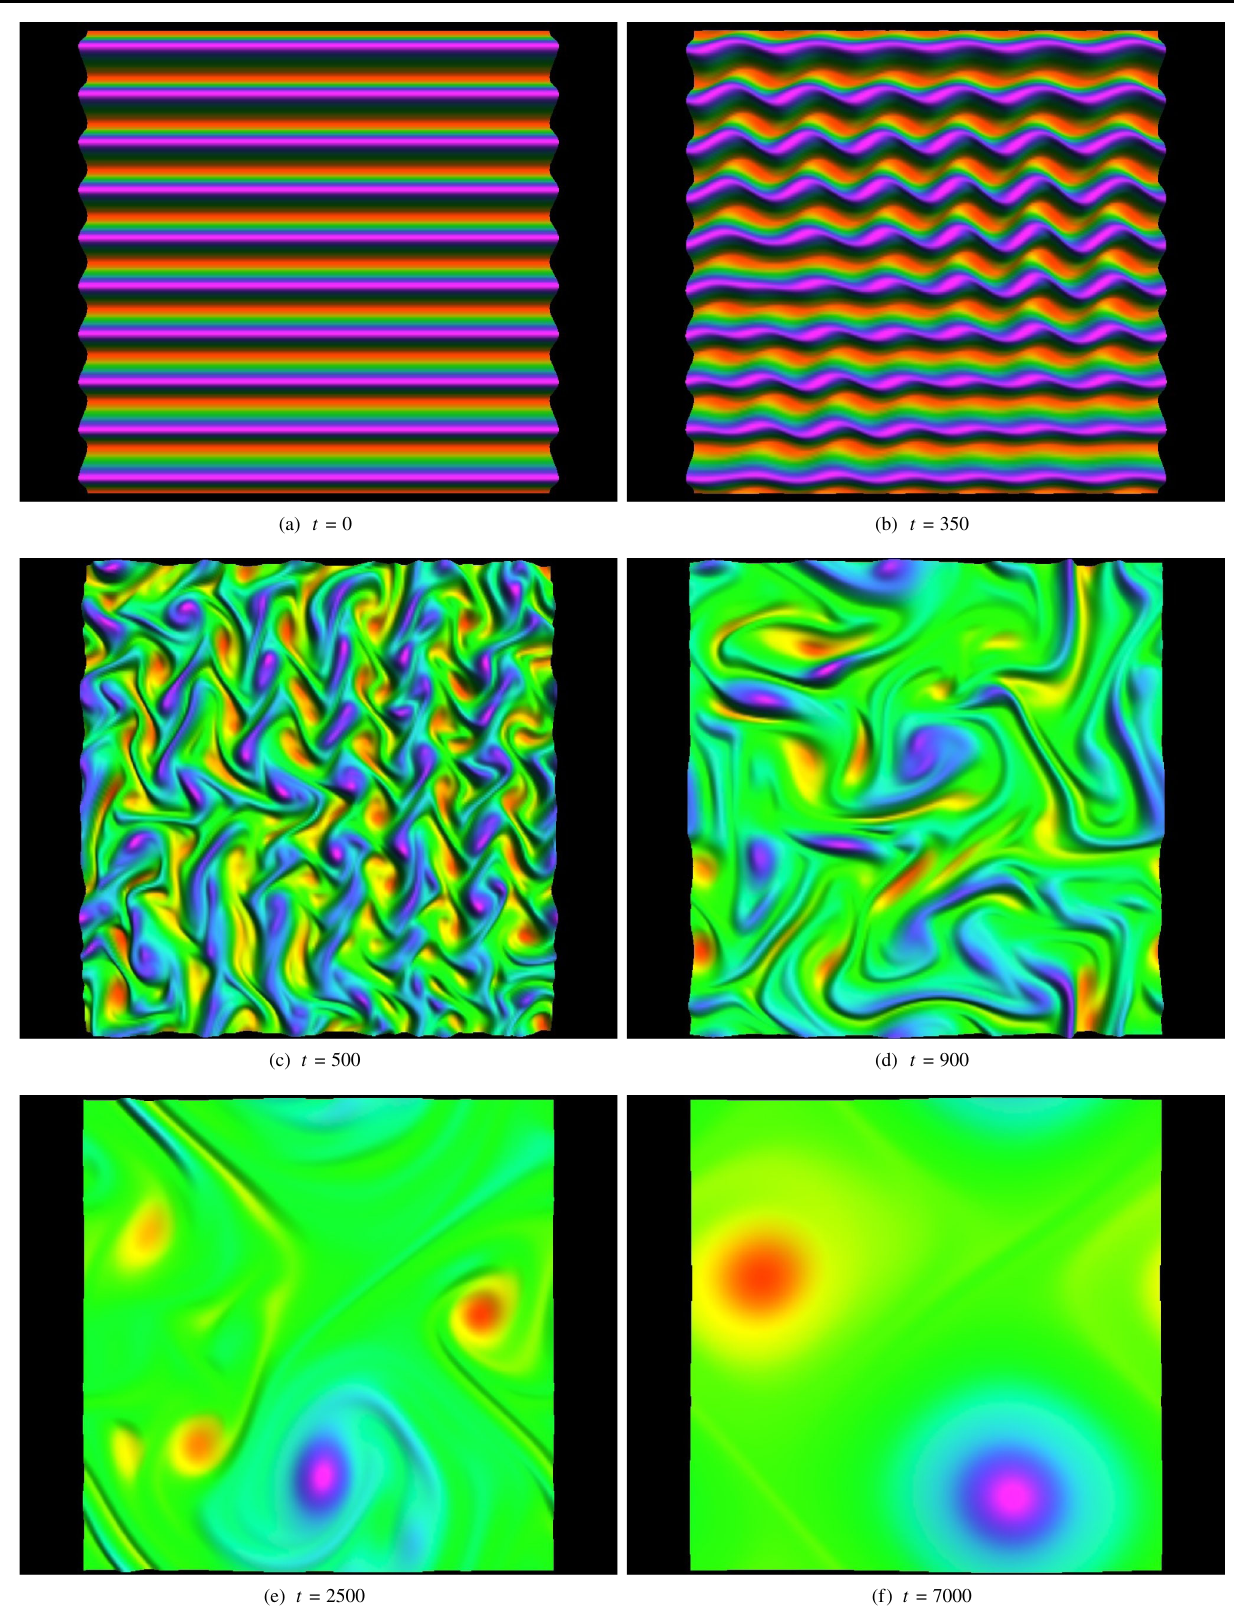
¼ 10 10 , v ¼ 0 : 05 , D ¼ 10 , n ¼ 10 ). The inverse cascade behavior is 0 0